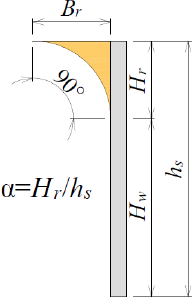
Figure 4. Schematics of a Large ReCurve wall (LRC).